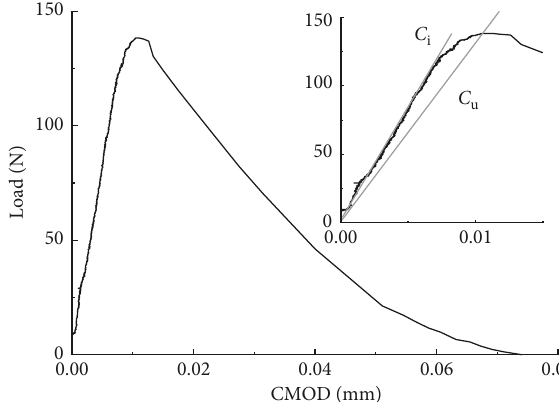
Figure 3: Typical load versus CMOD curve used to obtain C C u